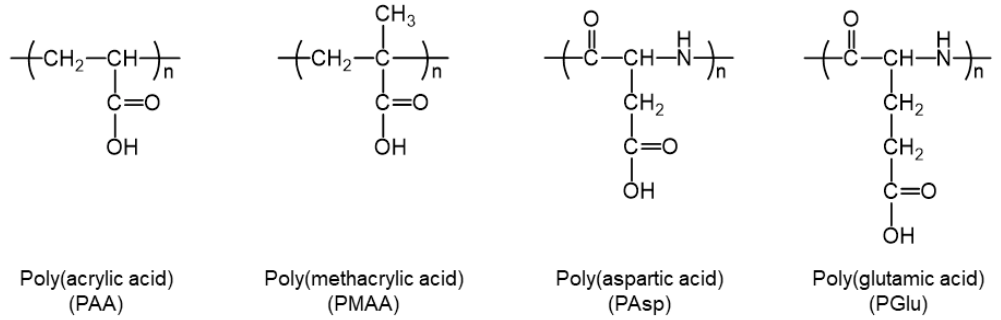
Figure 1. Chemical structures of polycarboxylates, where n indicates the degree of polymerization.